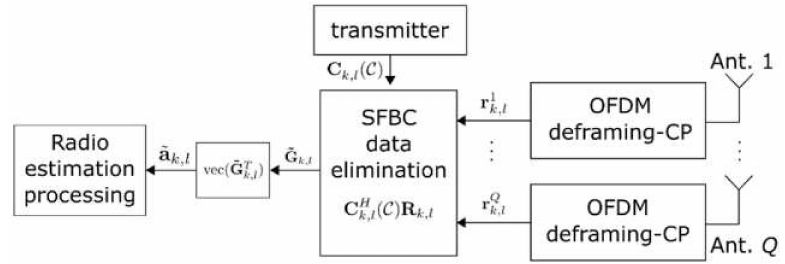
Figure 4. Co-located receiver schematic in MIMO-ISAC